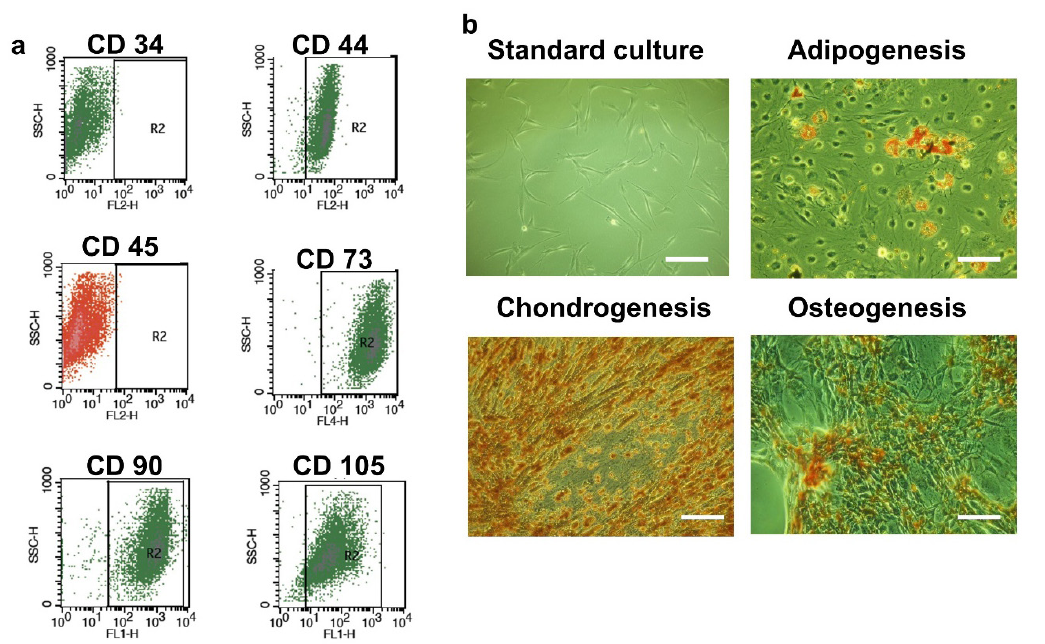
Figure 3: Multipotency assay of ASC. Adipogenesis was confirmed by the presence of intracellular lipid droplets using Oil Red O staining . Chondrogenic differentiation were visualized by staining proteoglycans with safranin O and Alizarin Red staining was performed to confirm osteogenesis by the presence extracellular mineralized matrix (a). Flow cytometry dot plots showing surface antigens expression by ASC (b). ASCs were characterized by the expression of CD 44, CD 73, CD 90 , CD 105 while lacked the expression of CD 34 and CD 45surface marker. Magnification: x100. Scale bar 200